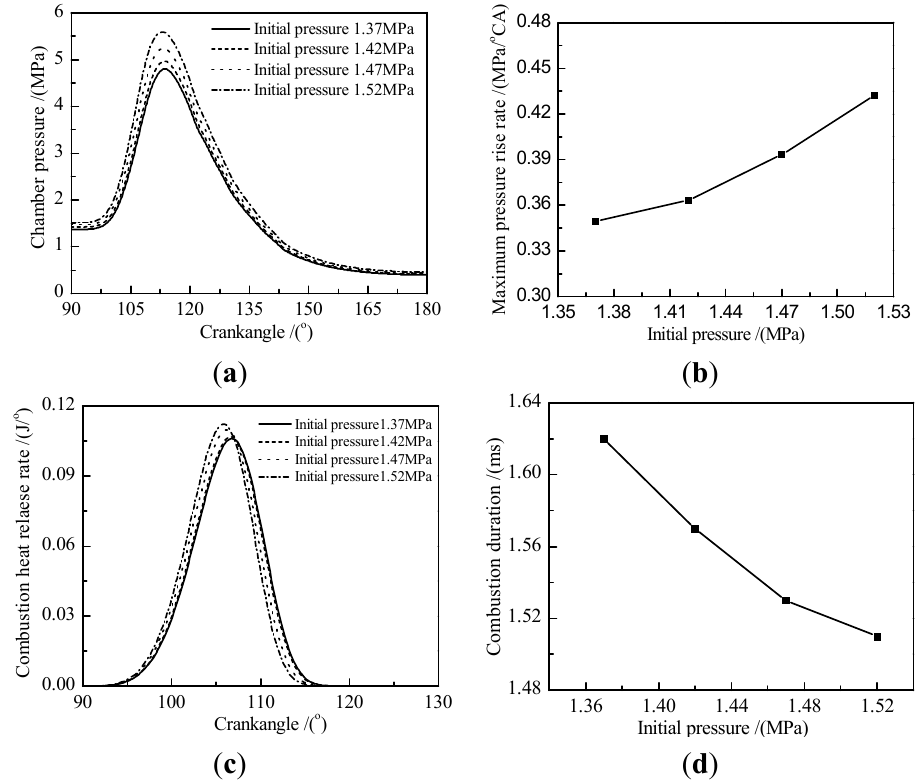
Figure 10. ( a ) Chamber pressure for initial pressure; ( b ) Maximum pressure rise rate for initial pressure; ( c ) Combustion heat release rate for initial pressure; ( d ) Combustion duration for different initial pressure.